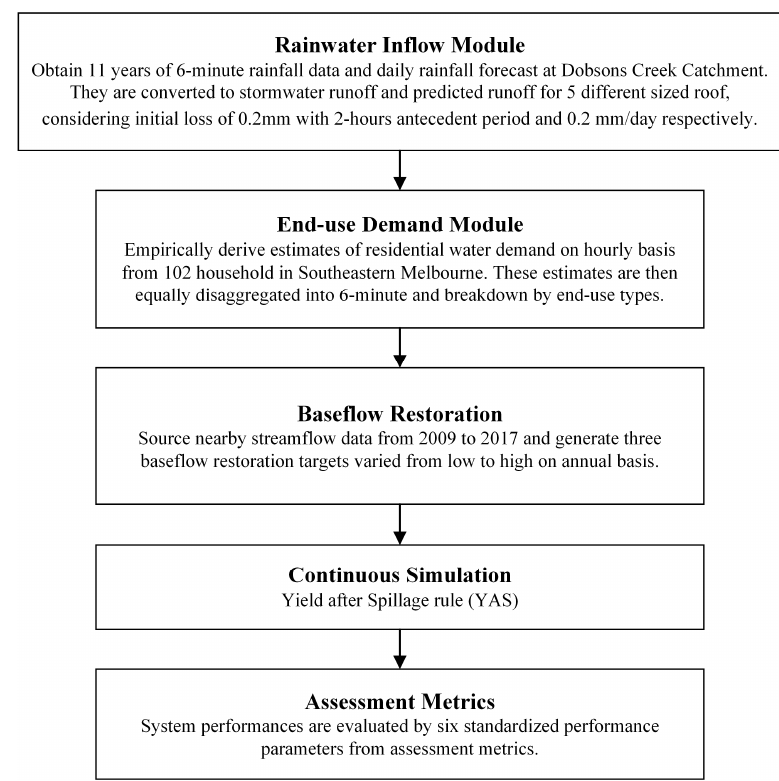
Figure 2. Modelling Flow Chart. All system simulations were run every 6-min.